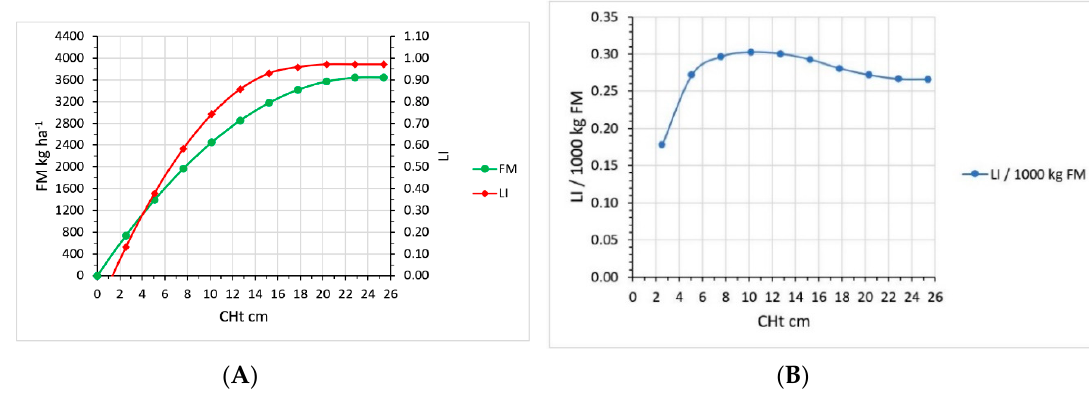
Figure 5. ( A ) Forage mass (FM, kg ha − 1 ) and light interception (LI, fraction amdient PAR) increase as pasture canopy plate meter compressed height (CHt, cm) increases. ( B ) At low CHt, LI efficiency per FM was low, increasing as CHt increased to 8 cm, then decreased slightly as CHt increased to 25 cm.